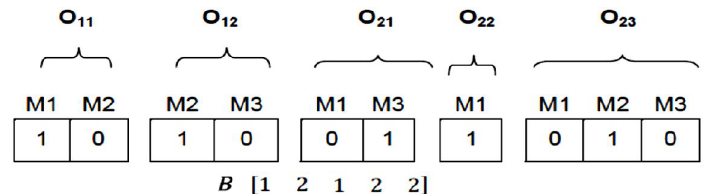
Fig. 2. Encoding the structure presented by Ho et al. (2007)